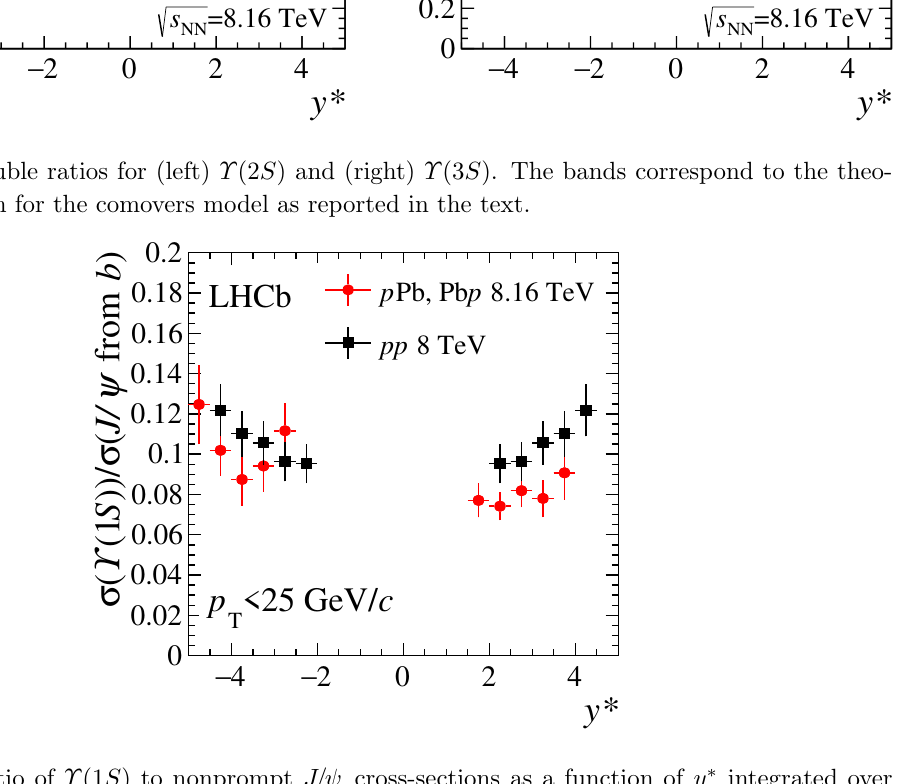
Figure 12 . Ratio of (cid:7) (1 S ) to nonprompt J= cross-sections as a function of y (cid:3) integrated over p T , for p Pb and Pb p